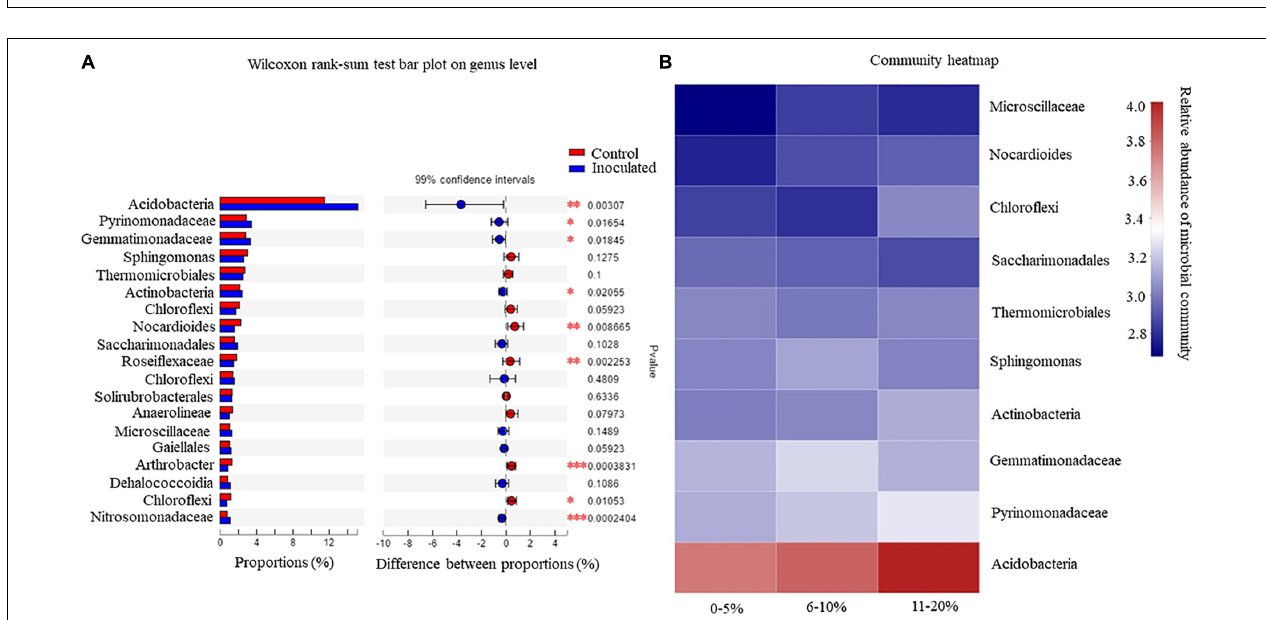
FIGURE 2 | (A) Wilcoxon rank-sum test analysis for the rhizosphere soil microorganisms. * P = significant, ** P = highly significant, *** P = extremely significant. (B) Community heatmap analysis of rhizosphere soil microorganisms.